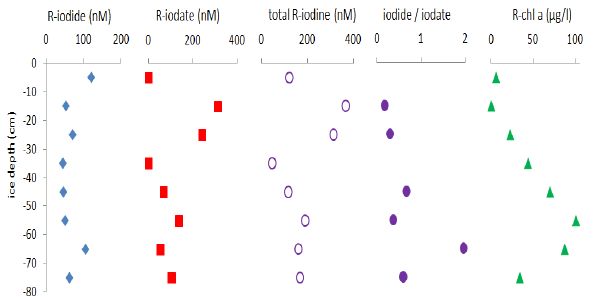
Fig. 9. Iodide, iodate and Chl a concentrations in the ice core of 13 March. Values have been normalised to brine volume and rationalised to salinity. Total iodine (iodide + iodate) and iodide / iodate ratios are also shown, except for the near-surface ratio where iodate was close to zero.